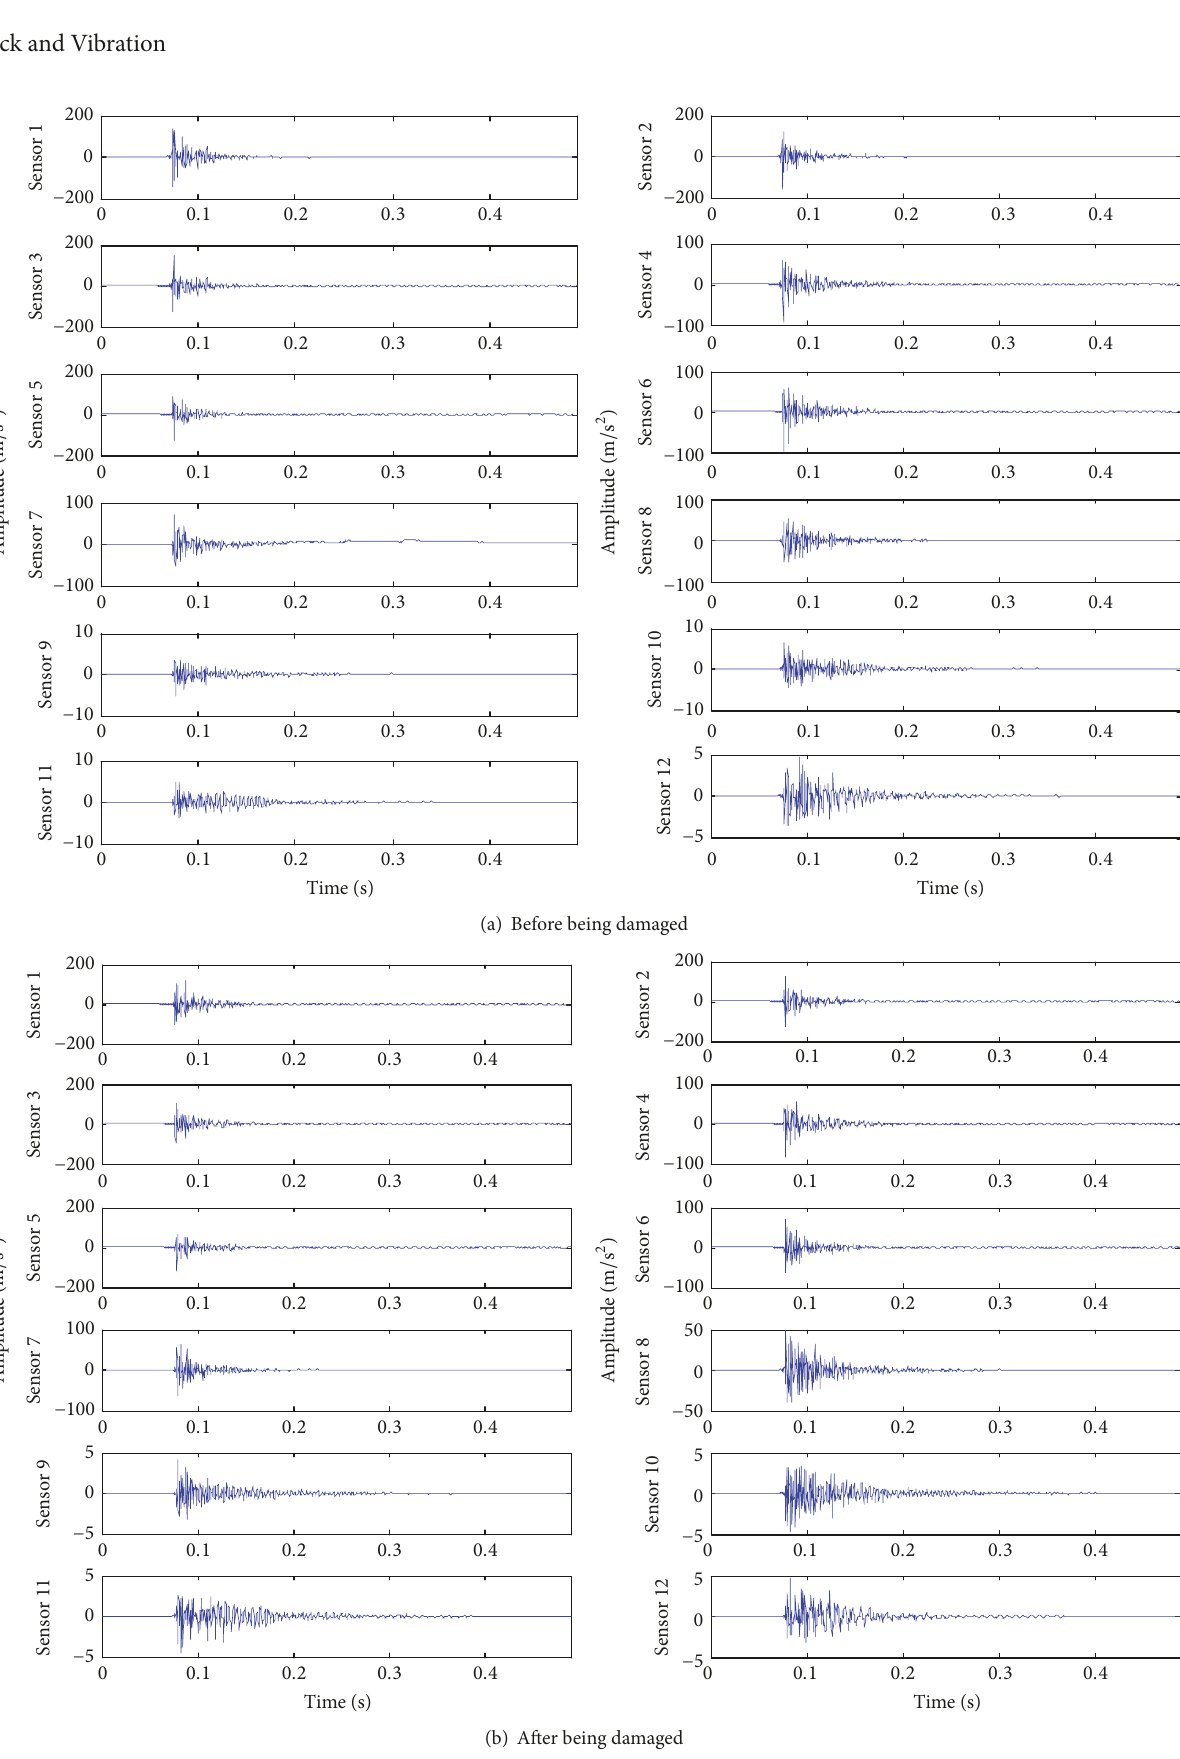
Figure 9: Time-domain signal of sensors 1–12 before and after the damage of the derrick steel structure under Condition